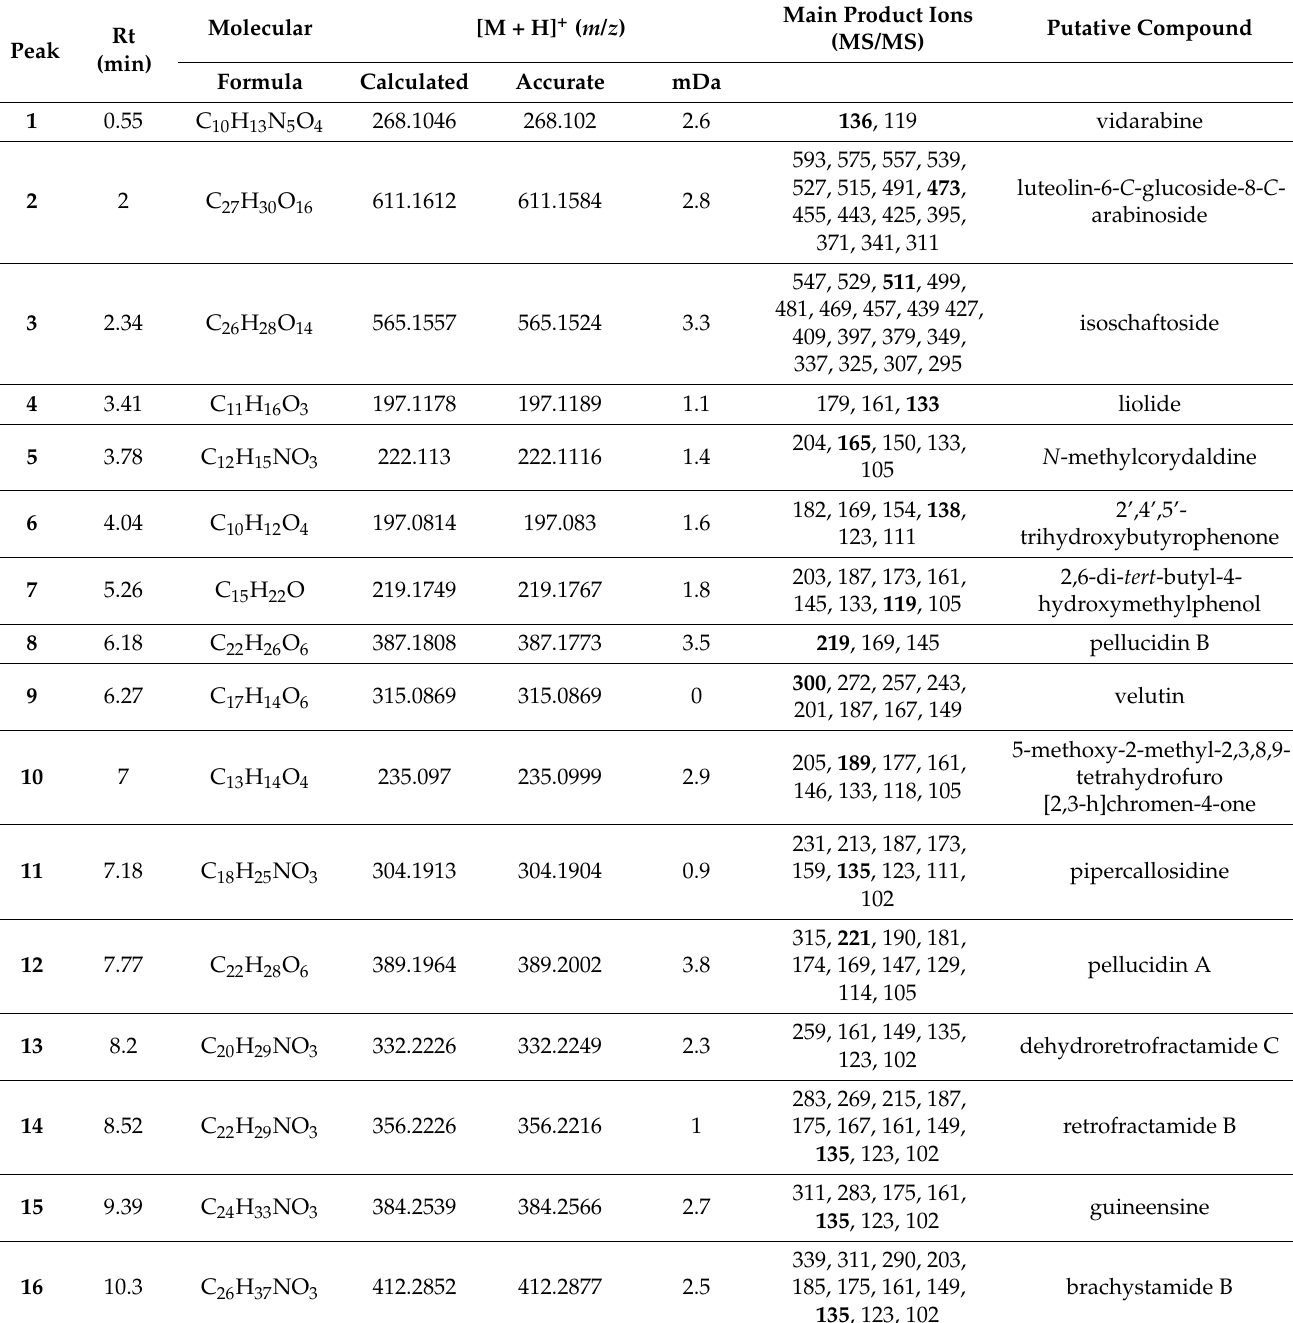
Table 1. UHPLC-MS/MS data of the main compounds annotated and propagated for each